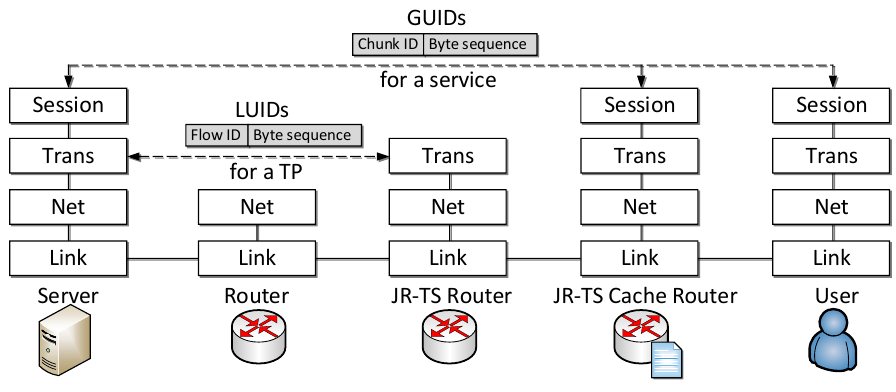
Figure 4. Protocol stack of session-based